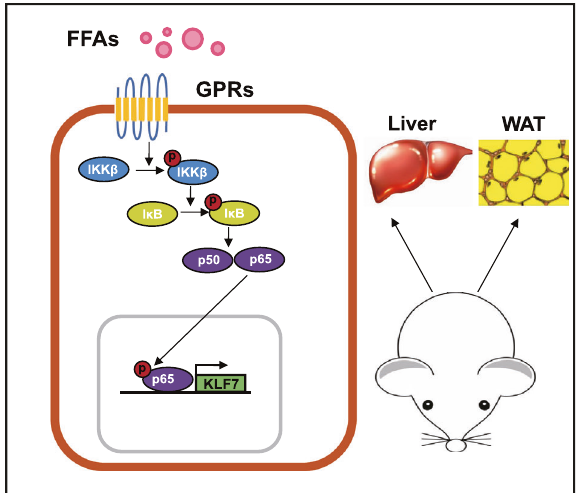
Fig. 7 Pattern diagram. Obesity-induced elevated palmitic acid can activate GPRs/NF- κ B signaling pathway in liver and adipose tissue, up-regulate the expression of KLF7, and ultimately lead to glucose metabolism